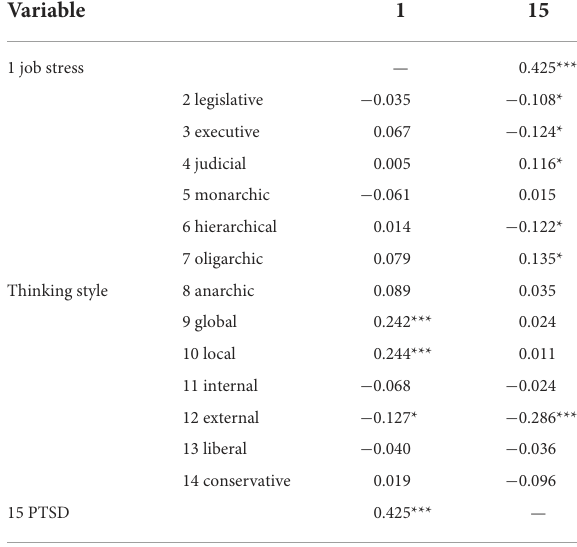
TABLE 2 Correlation between job stress, thinking style and PTSD.